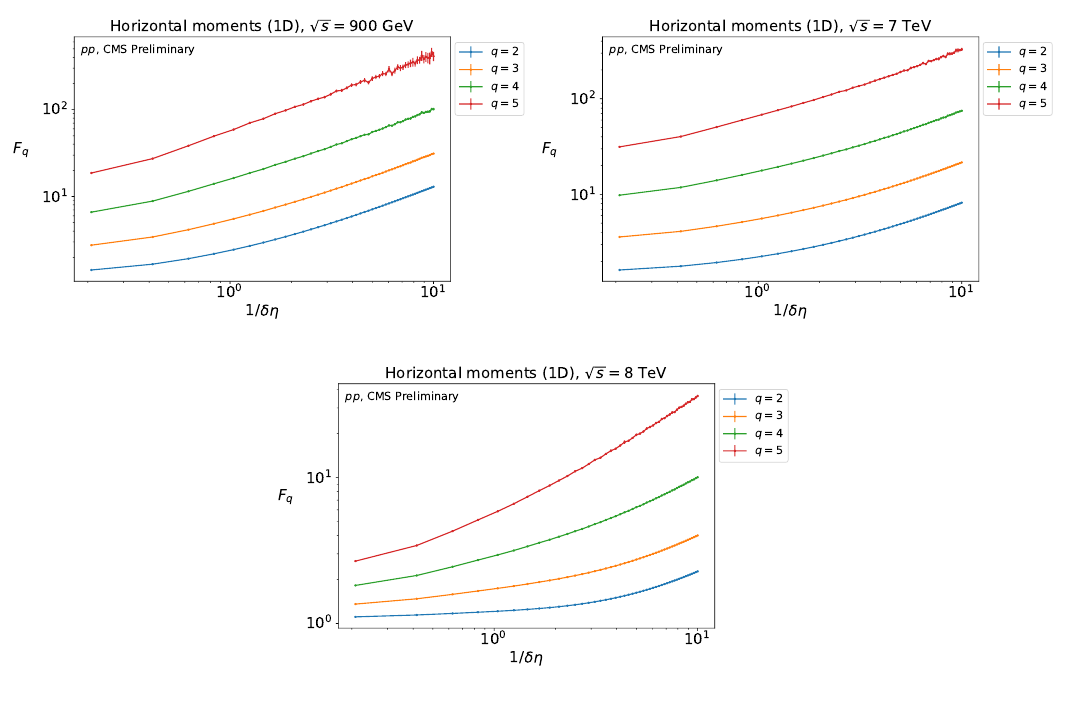
(cid:112) s = 0.9, 7 and 8